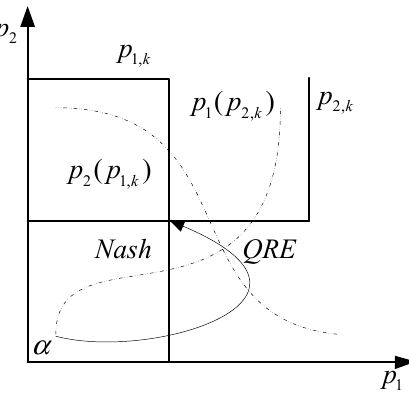
Figure 2. QRE moves toward Nash equilibrium.